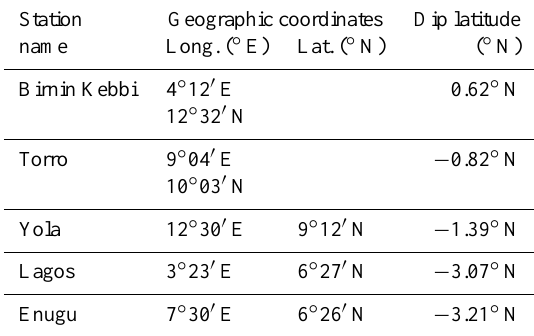
Table 1. Coordinates of the GPS